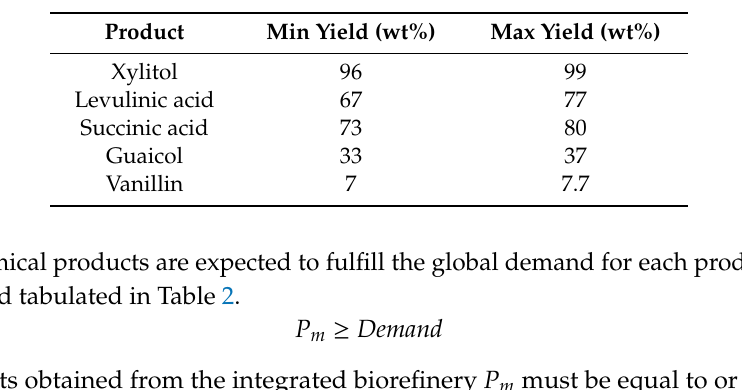
Table 1. The mass yield of each process.